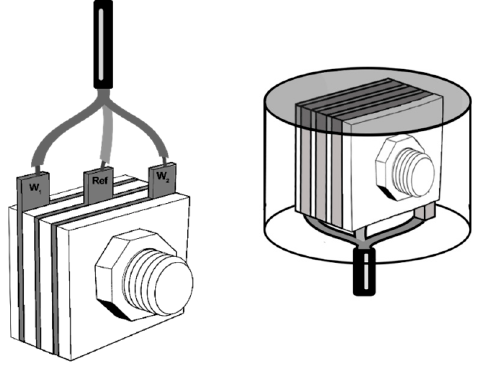
Figure 2. ACM monitor assembled.